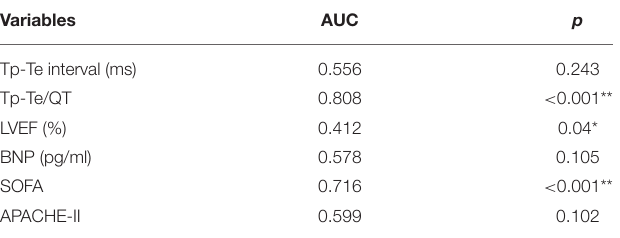
TABLE 5 | Analysis of the predictive value of clinical indicators by ROC